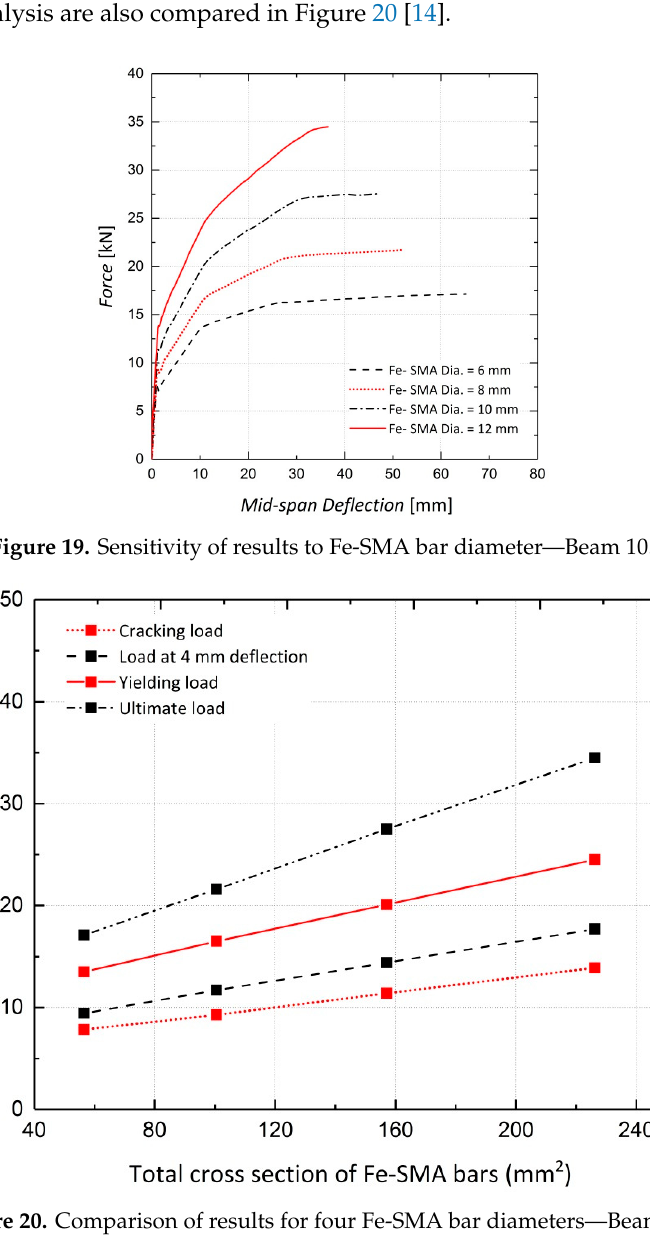
Figure 18. Finite Element analysis results for Beam 11 (pre-stressed by four Fe-SMA bars).